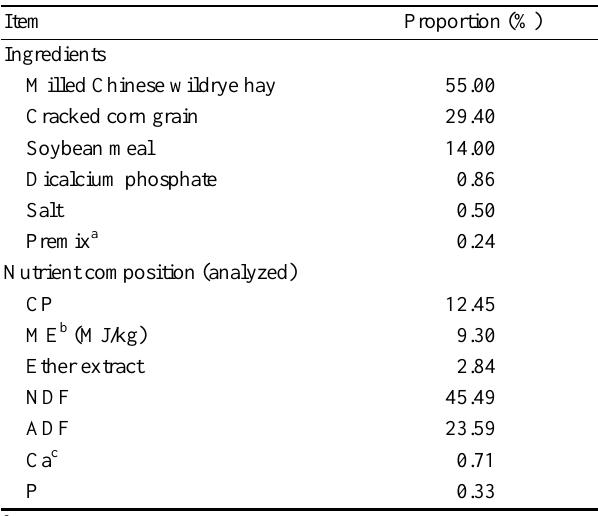
Table 1. Ingredients and nutrient composition of the